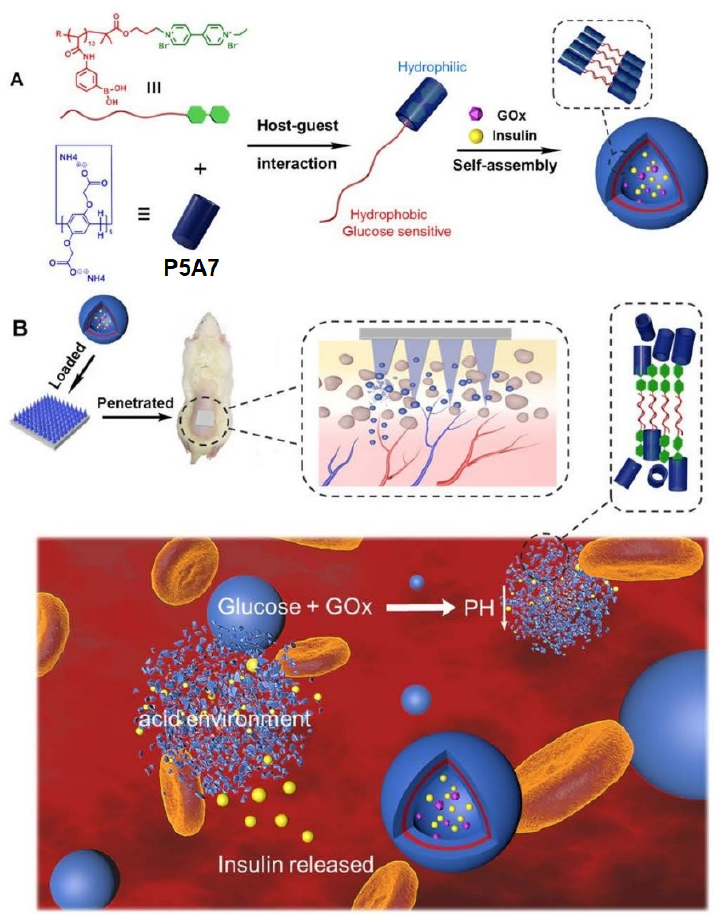
Figure 23. Schematic illustration of a stimuli-responsive P5A-based system and transdermal insulin delivery in a diabetic rat. ( A ): the preparation process of the stimuli-responsive system based on host − guest interaction; ( B ): drug-loaded patch for insulin release in vivo. Reproduced with the permission of reference [109]. Copyright © American Chemical Society 2020.